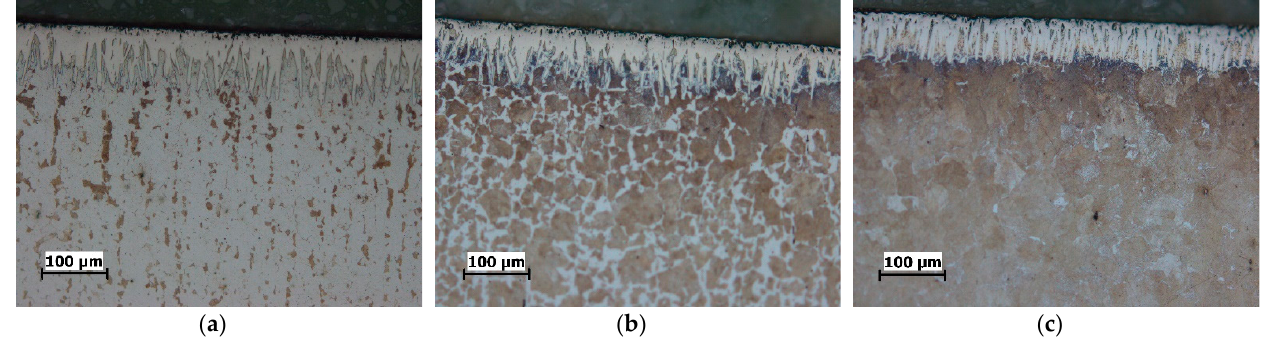
Figure 3. Microstructure of the boride layers obtained by boronizing at 870 °C for 8 h, magnification 200:1: ( a ) C15 steel; ( b ) C45 steel; ( c ) C70W2 steel.